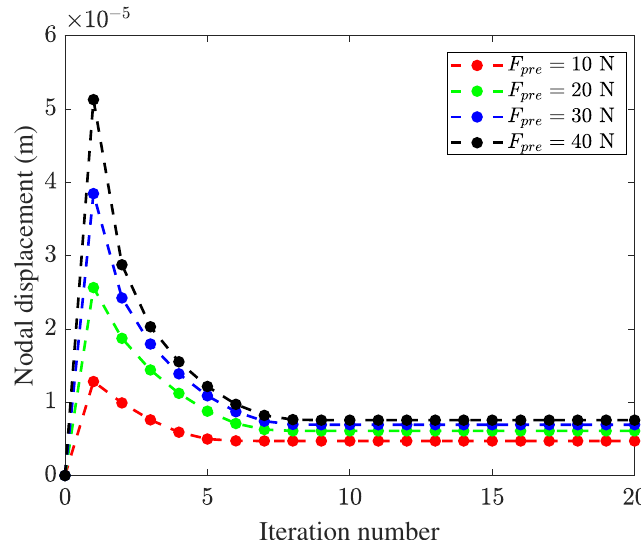
Figure 15. Nodal displacement monitor in an iterative process.